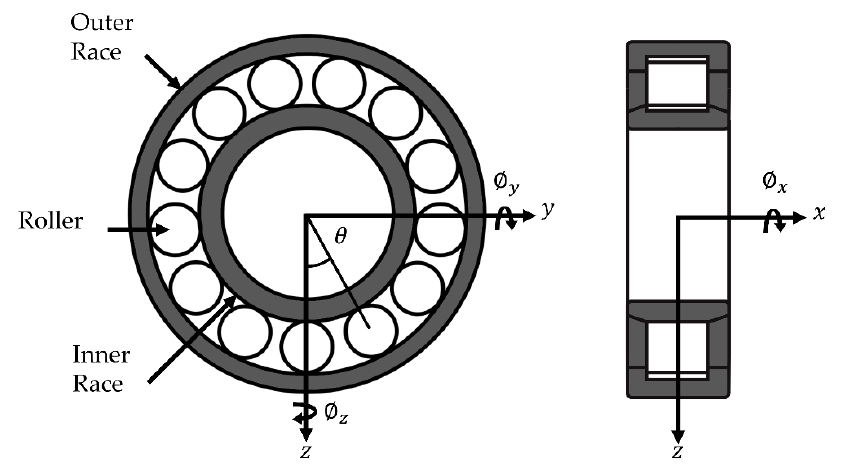
Figure 3. Bearing Schematic.